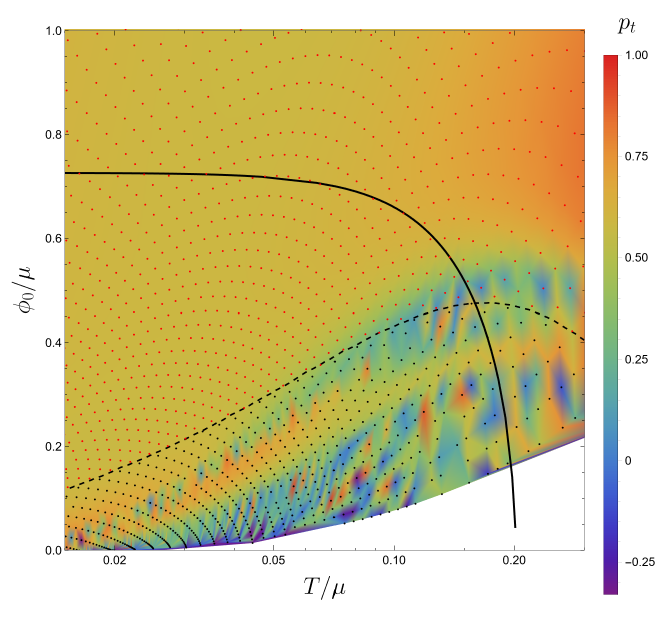
Figure 10 . The Kasner exponent p t as a function of the parameter space for q = 1 . The black solid line is the line of zero source φ 1 = 0 with spontaneous condensation. The white region in this plot is where our numeric procedure didn’t converge. The plot shows the last value of p t displayed by our solutions at the maximum possible value of z . The dashed line divides Type U (below) and type D (above)